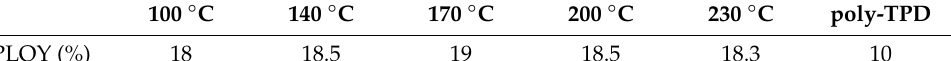
Table 1. Summary of photoluminescence quantum yields (PLQY) values of VB-FNPD films annealed at di ff erent temperatures.